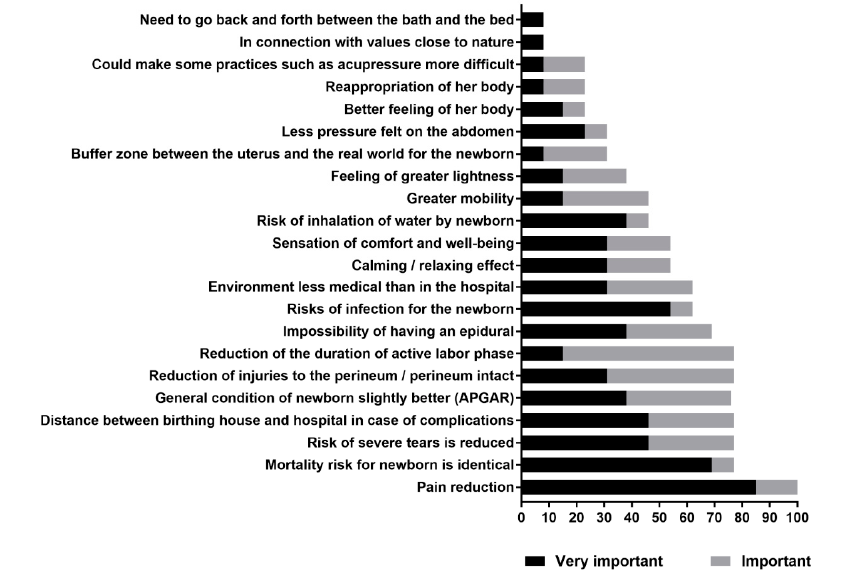
Figure 2. Classification of characteristics according to their importance for choosing to give birth in water.